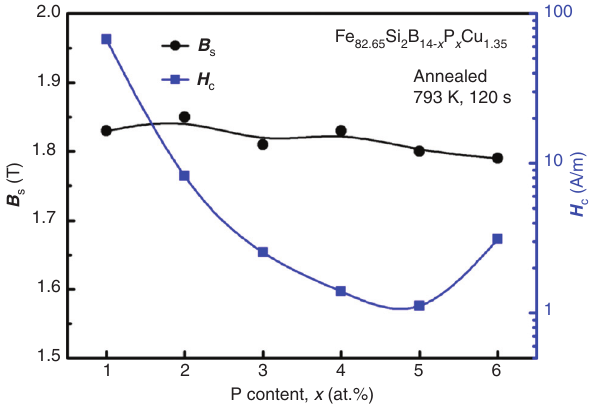
and H for Fe Si B P Cu ( x = 1–6) alloys s c 82.65 2 14– x x 1.35